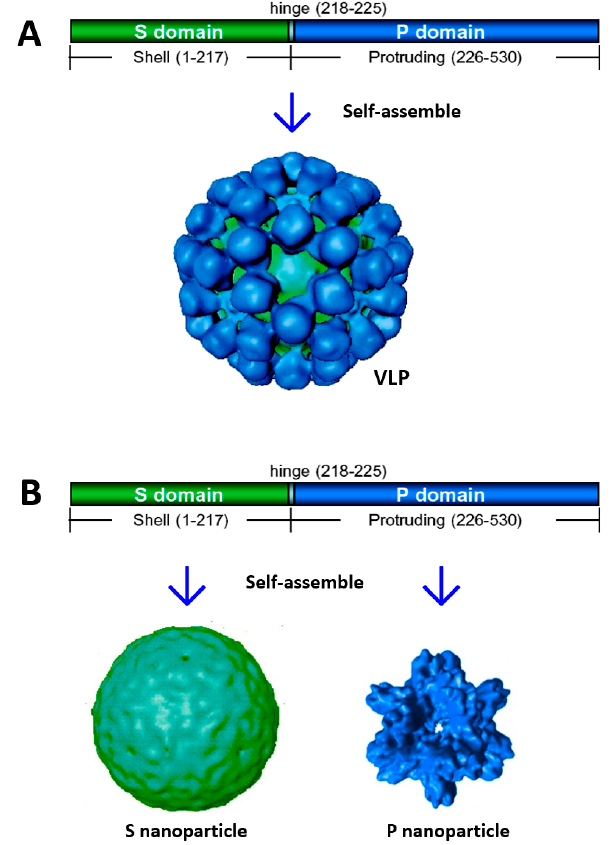
Figure 1. Lineage structures of norovirus capsid protein or viral protein 1 (VP1) and various nanoparticles derived from full-length or truncated VP1. The N-terminal shell (S) (green) and the C-terminal protruding (P) (dark blue) domains with a short flexible hinge (light blue) in between (with amino acid numbers based on GI.1 Norwalk virus VP1) are shown. ( A ) Production of full-length norovirus VP1s via a eukaryotic expression system self-assembles into virus-like particles (VLPs). ( B ) Production of the S or P domain via the Escherichia coli expression system self-assembles into S or P nanoparticles.